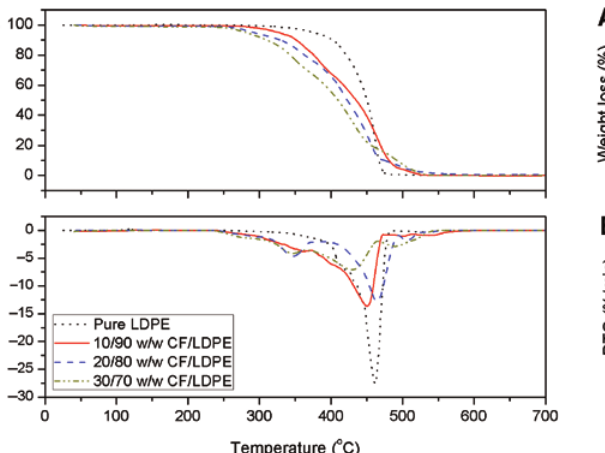
Figure 5: TG (A) and DTG (B) curves of LDPE, and the CF/LDPE composites at different fiber content.